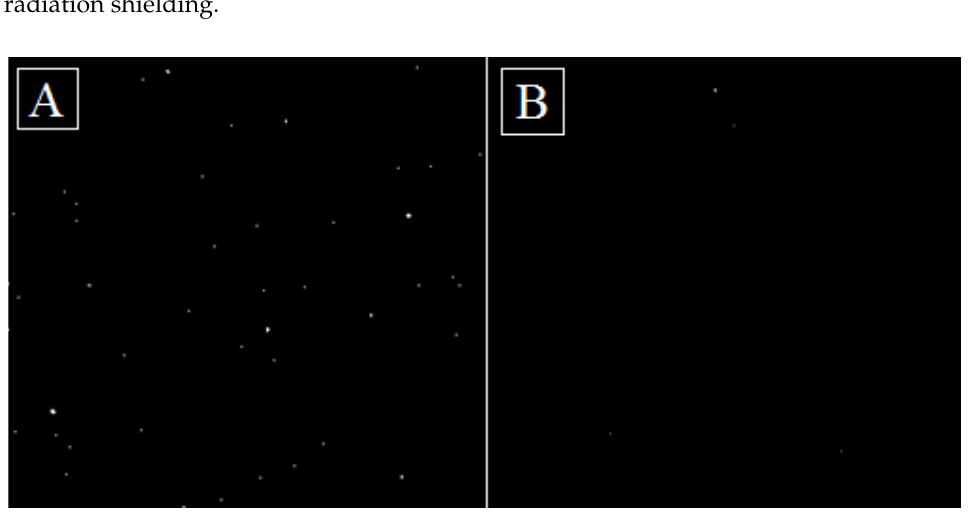
Figure 10. Threshold image captured with ( A ) unprotected camera and ( B ) protected camera.